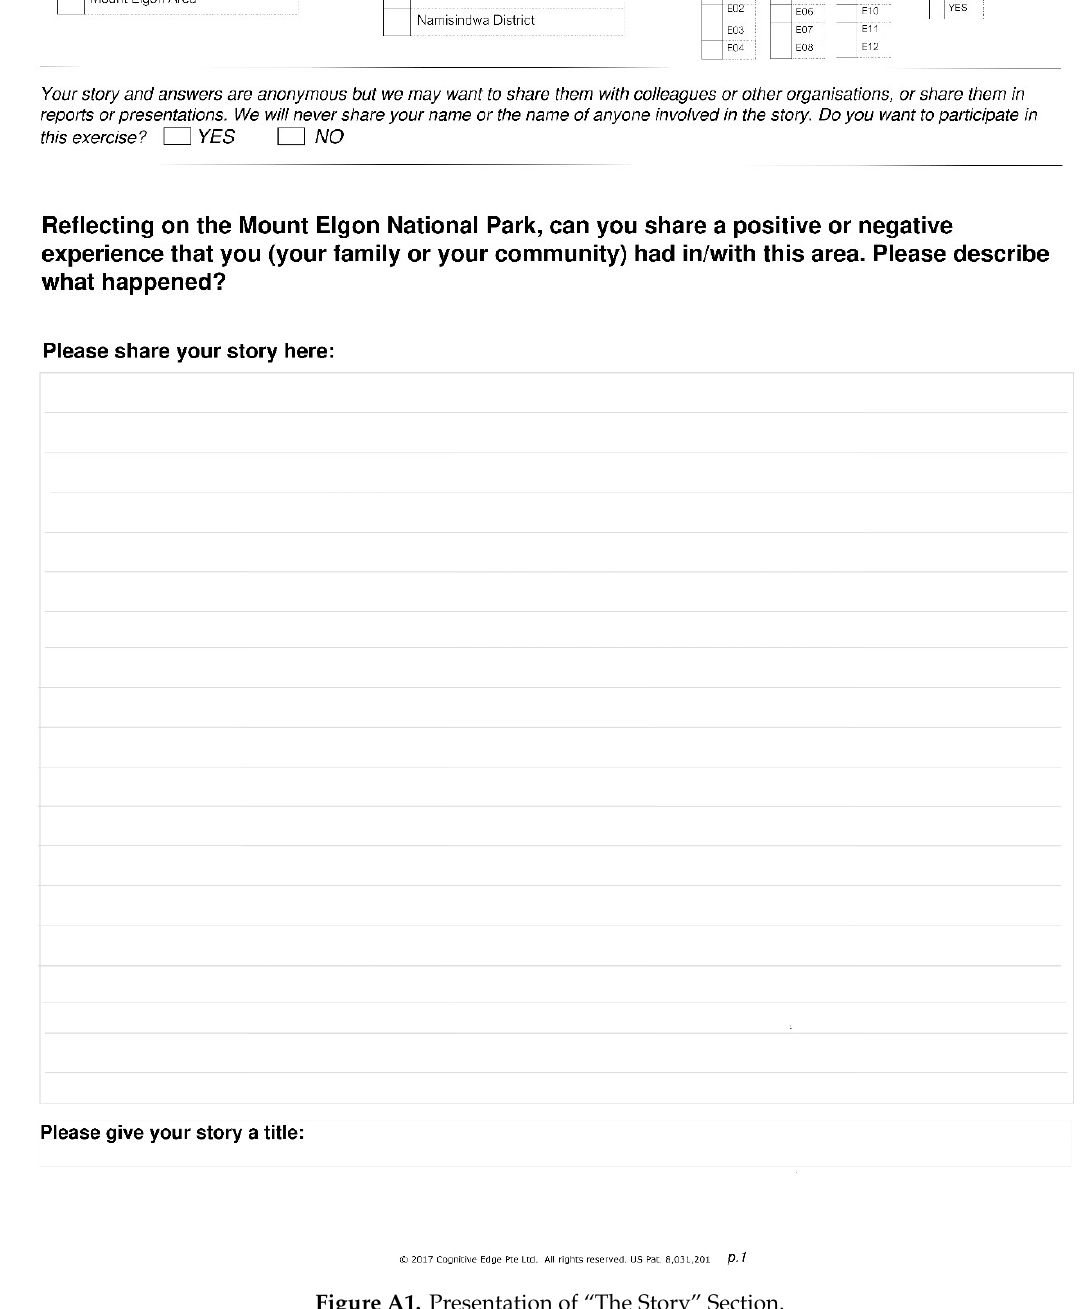
Figure A1. Presentation of “The Story” Picture A1: Presentation of “The Story” Section